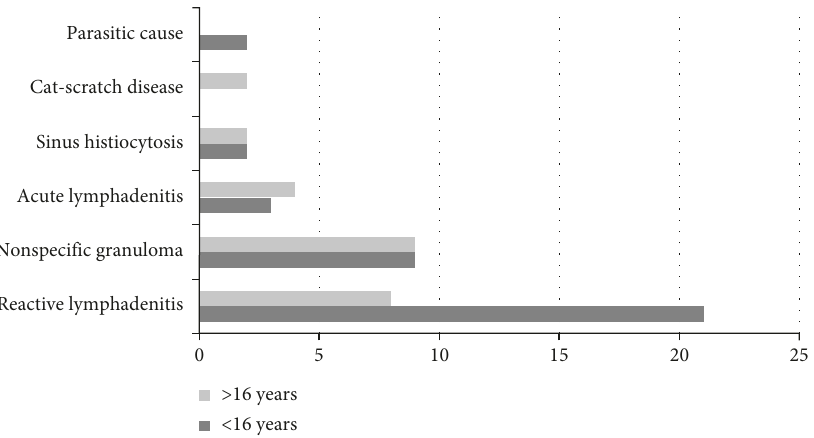
Figure 1: The findings of nonsignificant pathologies in the lymph nodal biopsies ( n � 62 )